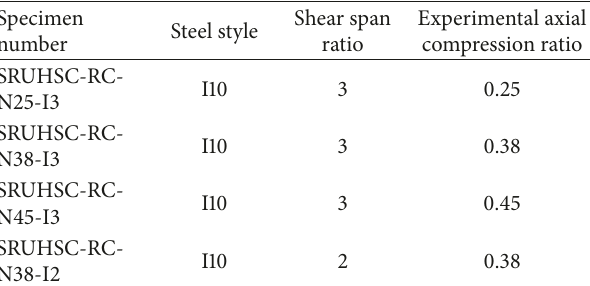
Table 4: Design parameters of the